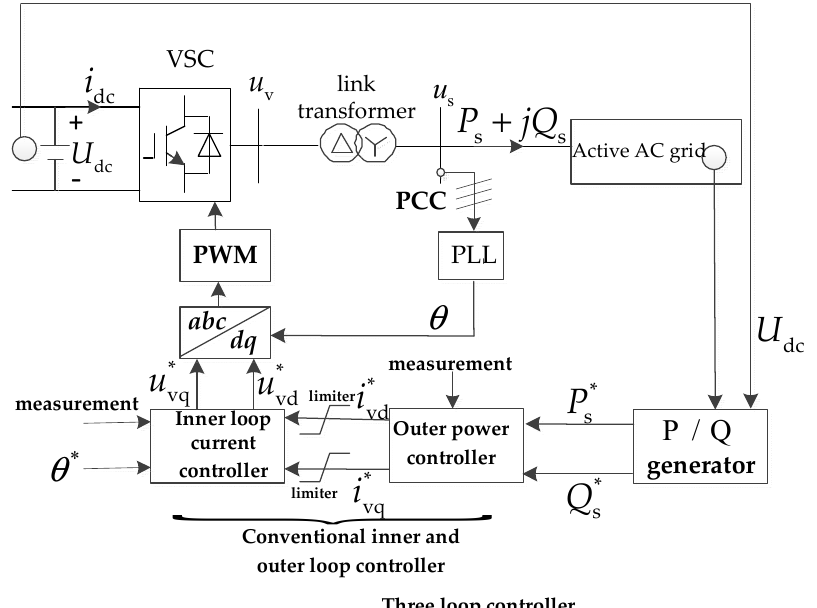
Figure 5. Three loop controller diagram of the PQ type grid-following nonsynchronous-machine source .